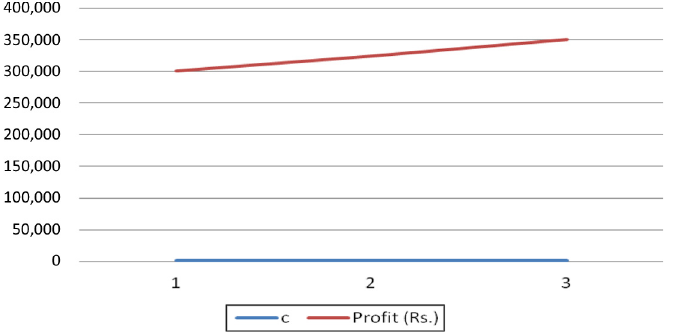
Figure 1. 3 years pro fi t to cost statement of Balaji